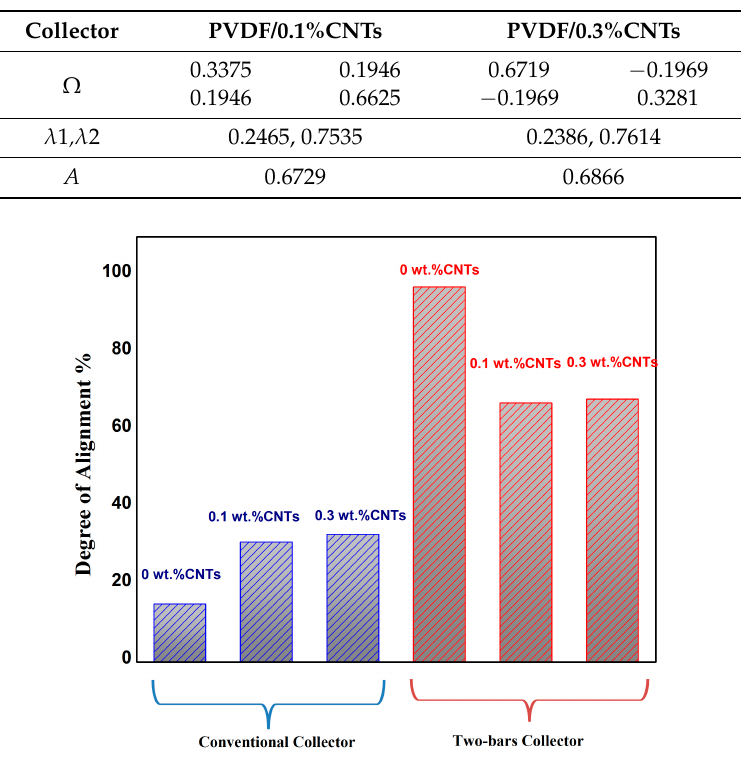
Figure 7. Alignment degree for nanofibers collected on the two-bars and conventional collector.